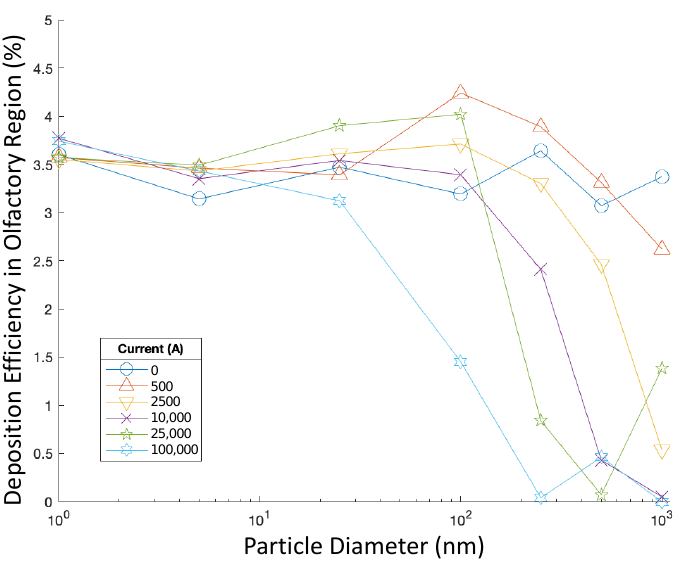
Figure 11. Olfactory deposition efficiencies of particles of varying size injected at 1 m/s in varying magnetic fields using targeted